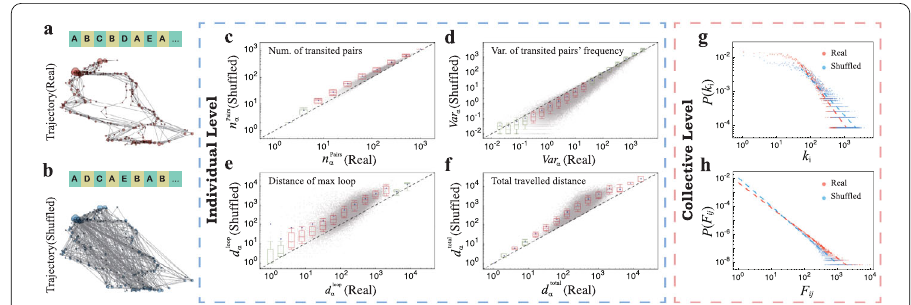
Figure 1 Comparison of the statistical properties of the human mobility in the real and the shuffled data. An illustration to compare ( a ) the real and ( b ) the shuffled travel trajectory of a typical cell phone user. Here each node is a location visited by the user, with node size proportional to its visitation frequency. A link is drawn when the user has traveled at least once between the two locations. The shuffled data is obtained by randomly reordering the sequence of visited locations. In this way, the visitation frequency of each location by the user is preserved while the travel trajectory is randomized. ( c - f ) Scatter plots comparing the statistical properties between the real data and the shuffled data for each user α at the individual level, in terms of ( c ) the total transited location pairs n pairs α , ( d ) the variance Var α of the traveled frequency of location pairs, ( e ) the covered distance d loop α of the maximum loop, and ( f ) the total traveled distance d total α . A box in the standard boxplots are marked in green if the line y = x lies between 10% and 91% in each bin and in